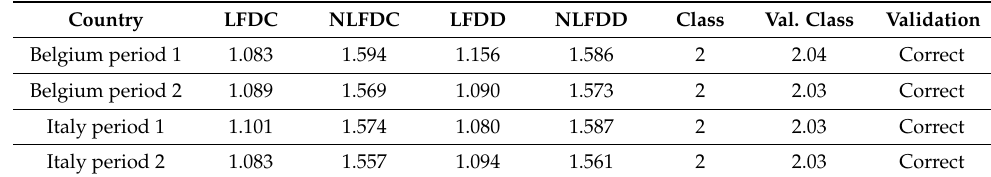
Table 4. Validation of the Fuzzy Fractal Classification Method for Belgium and